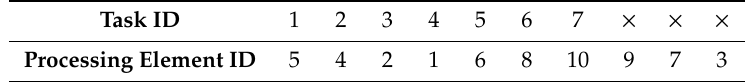
Table 2. Encoding example ( M > N ).